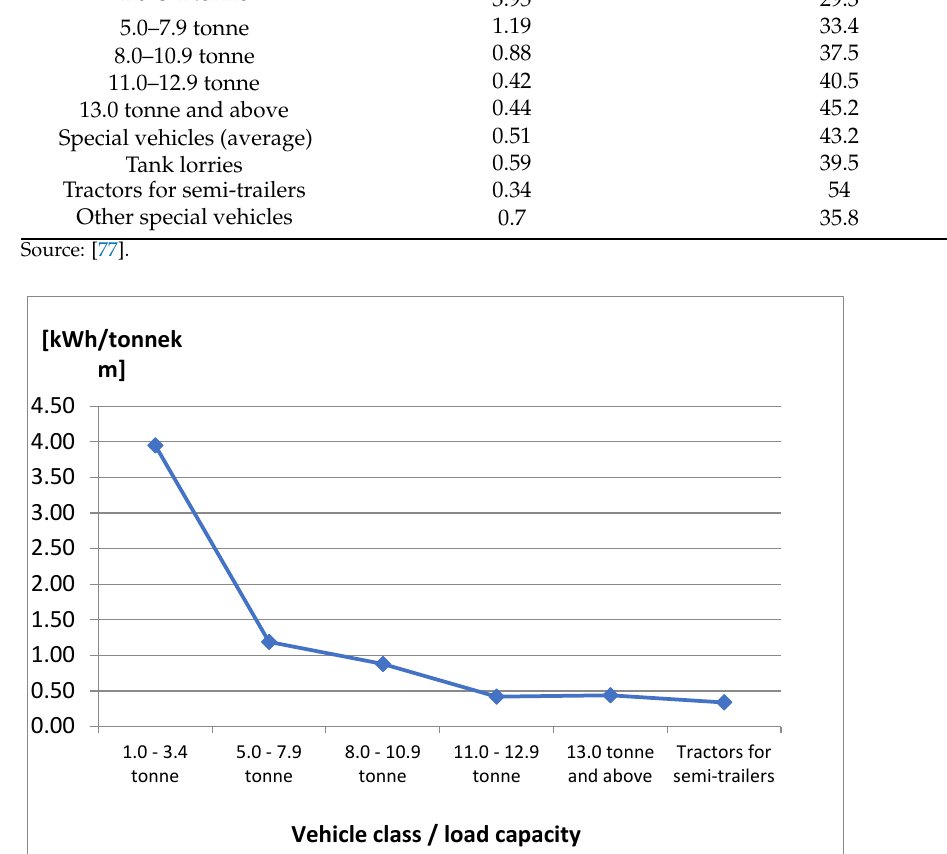
Figure 1. Energy efficiency in Norwegian domestic goods transport on road, 1993–1995 (load factor) [77].